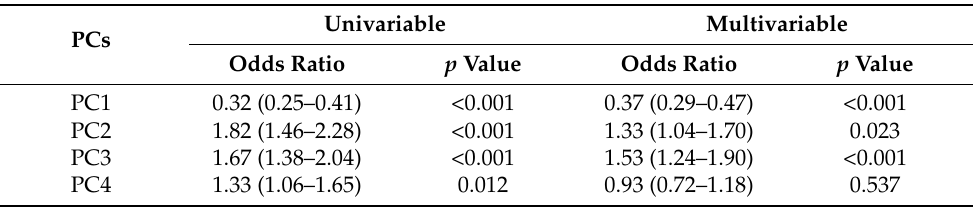
Table 5. Logistic regression analysis of components predicting mortality in patients with acute pesticide poisoning. Univariable PCs